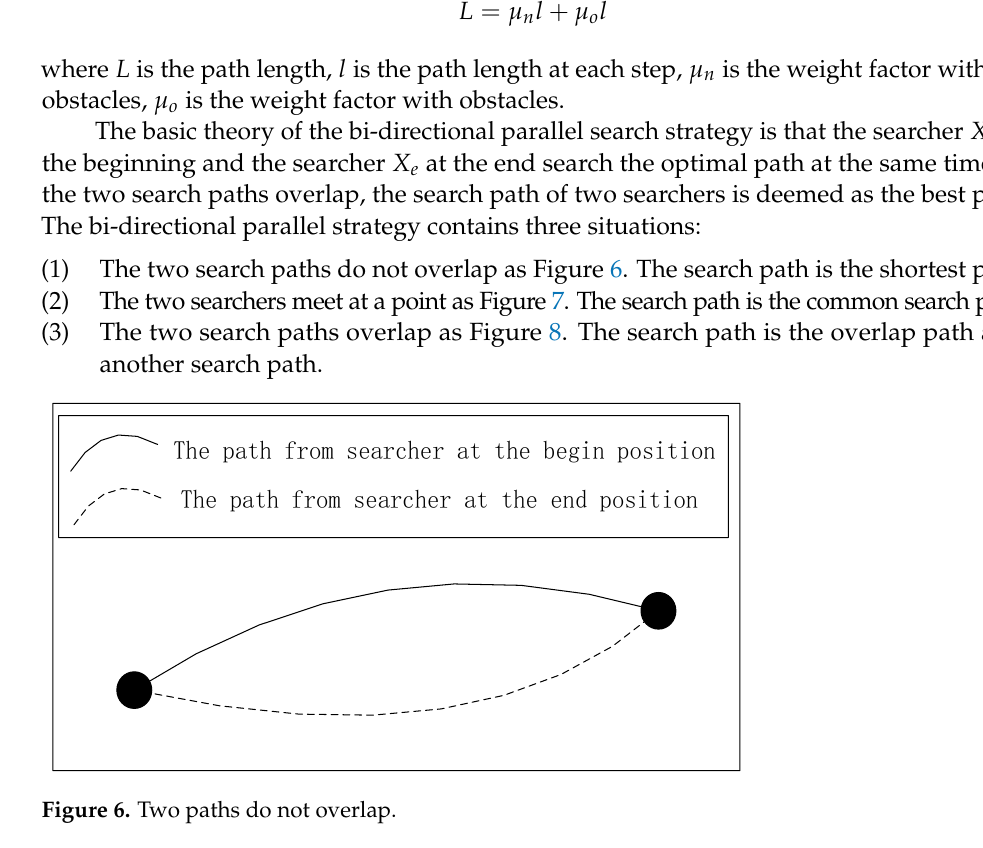
Figure 6. Two paths do not overlap.